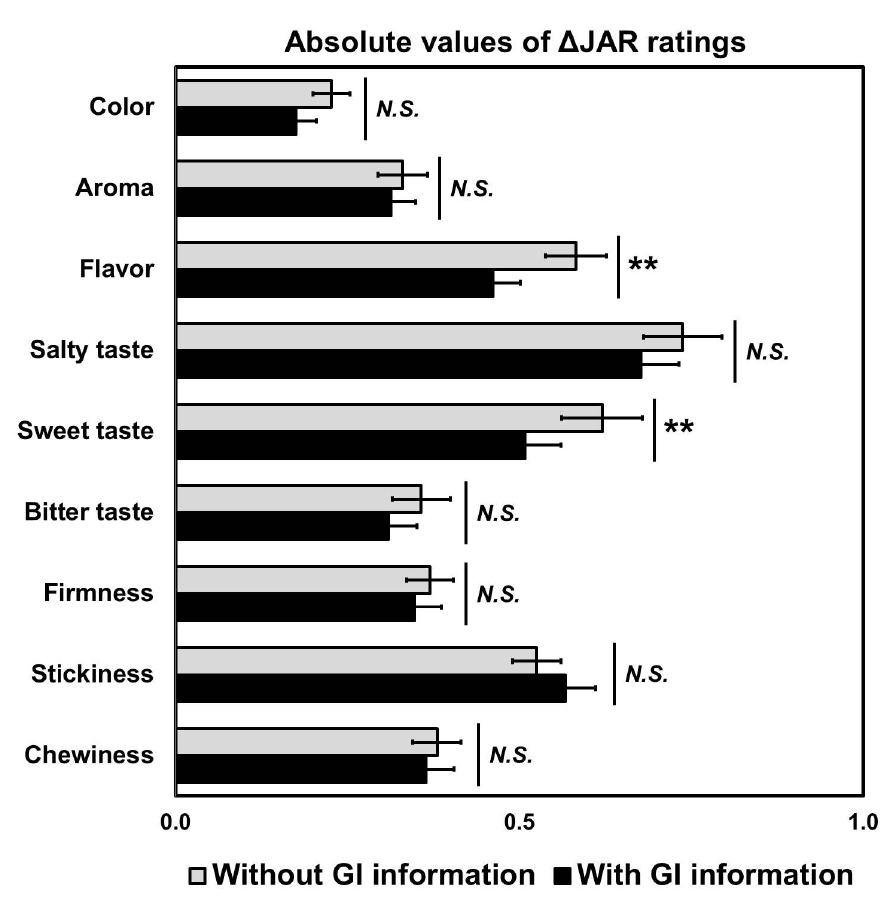
Figure 7. Comparisons between the two geographical indication (GI) information conditions with respect to absolute delta of Just-About-Right (JAR) ratings. The absolute delta ( | ∆ | ) JAR scores were computed by subtracting each JAR rating from the just-about-right value (i.e., 3). ** represents a significant di ff erence at p < 0.01. Di ff erent letters with mean ratings within a category indicate a significant di ff erence at p < 0.05. N.S. represents no significant di ff erence at p < 0.05.